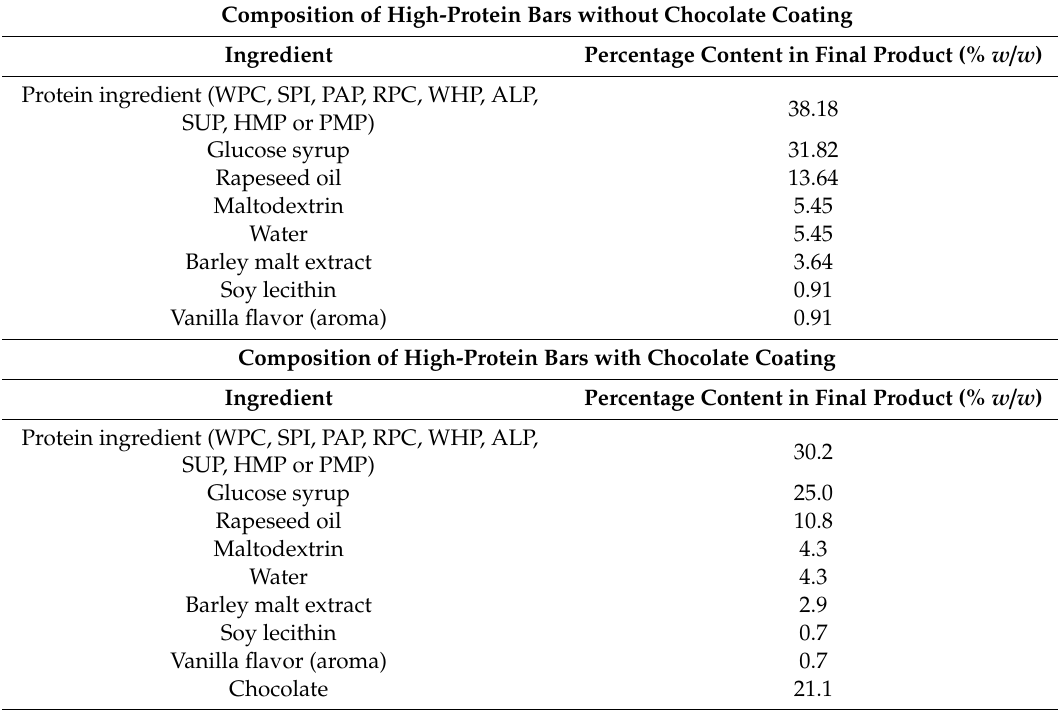
Table 1. Composition of high-protein